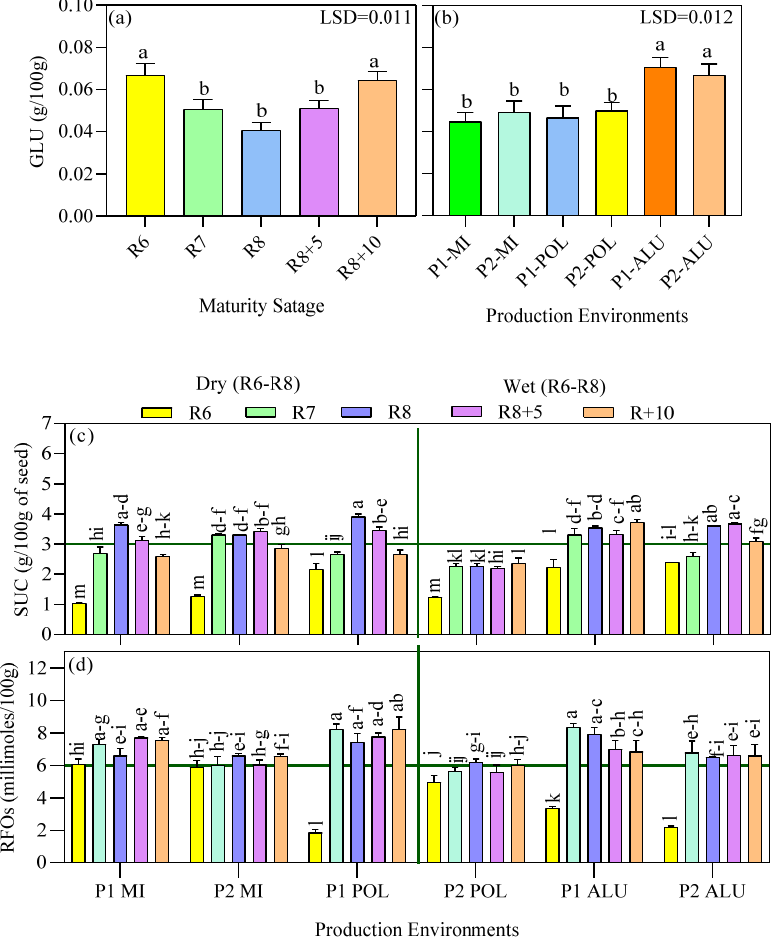
Figure 5. Glucose (GLU) content of the seed as affected by different maturity stages ( a ) and production environments (location x planting cycle) ( b ). Means followed by the same letter on the bar do not differ significantly based on LSD at p < 0.05. Sucrose (SUC) ( c ) and RFOs ( d ) as affected by the interaction between the production environment (location x planting cycle) and maturity stages. Means followed by the same letters do not differ significantly between the production environments x maturity stages using Ls means at p < 0.05.